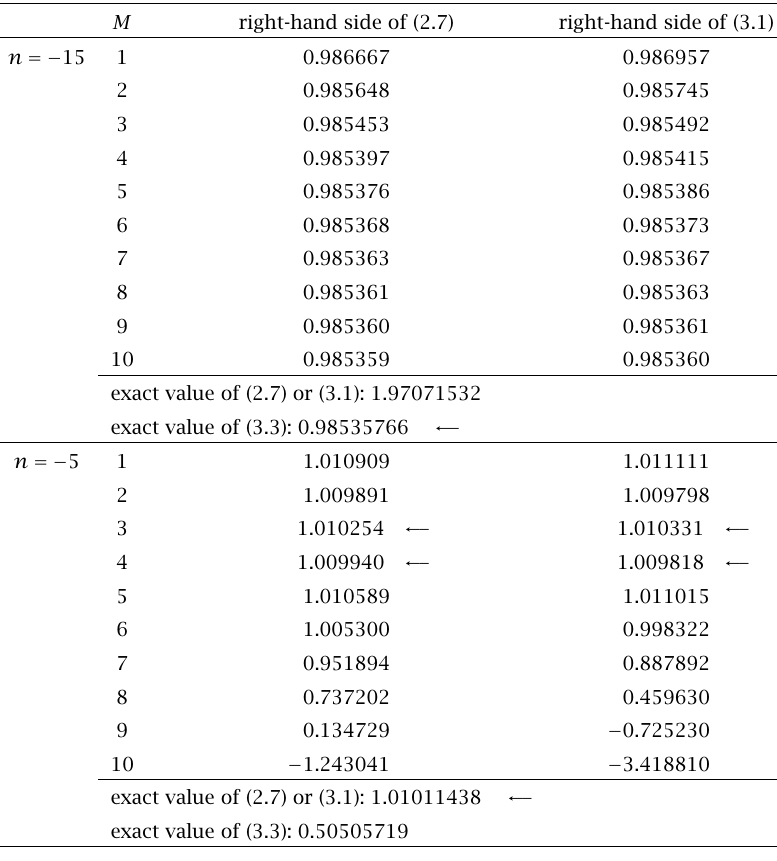
Table 3.2 . Values of the right-hand sides of (2.7) or (3.1) for the parameters a = 11 . 7, b = 11 . 2, c = 11 .